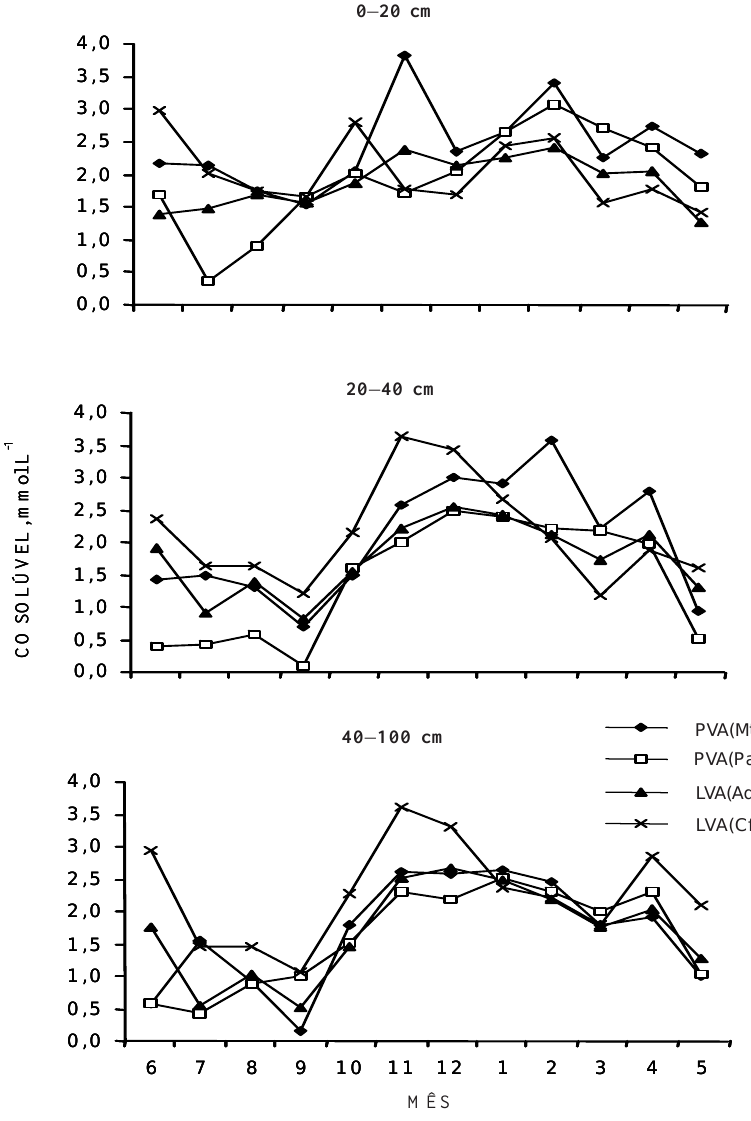
Figura 6. Variação mensal da concentração de carbono orgânico solúvel na solução do Argissolo Câmbico sob mata (PVA(Mt)) e sob pastagem (PVA(Pa)) e do Latossolo Vermelho-Amarelo sem cobertura vegetal (LVA(Ad)) e sob cafeeiro (LVA(Cf)), no período de junho de 1996 a maio de 1997, em três profundidades. Média de três